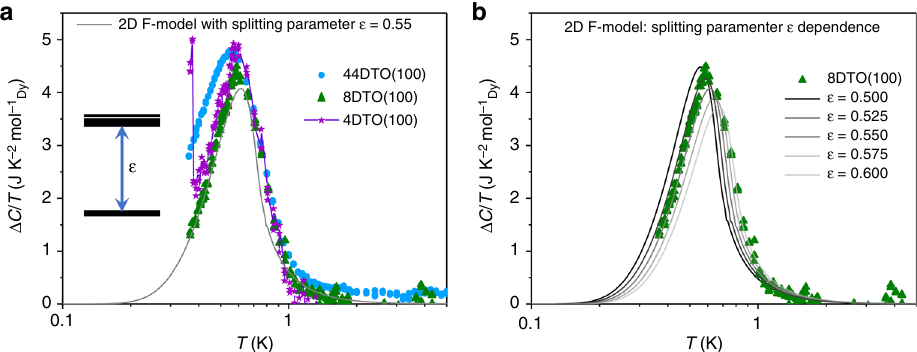
0.1 Fig. 4 Two-dimensional (2D) F-model realisation. a Residual of the speci fi c heat for the series of thin fi lms x DTO||YTO(100) with x = 4, 8, 44 monolayers, after subtraction of the bulk DTO contribution. The full line (grey) is the exact solution for the 2D F-model with splitting parameter ε = 0.55 K. Inset shows energy splitting of the Pauling manifold, that is, from six degenerate states per tetrahedron to two ground states plus four excited states. b Splitting parameter dependence of the calculated 2D F-model residual speci fi c heat (lines) plotted against 8DTO||YTO(100) as a guide to the eye. DTO Dy 2 Ti 2 O 7 , YTO Y 2 Ti 2 O